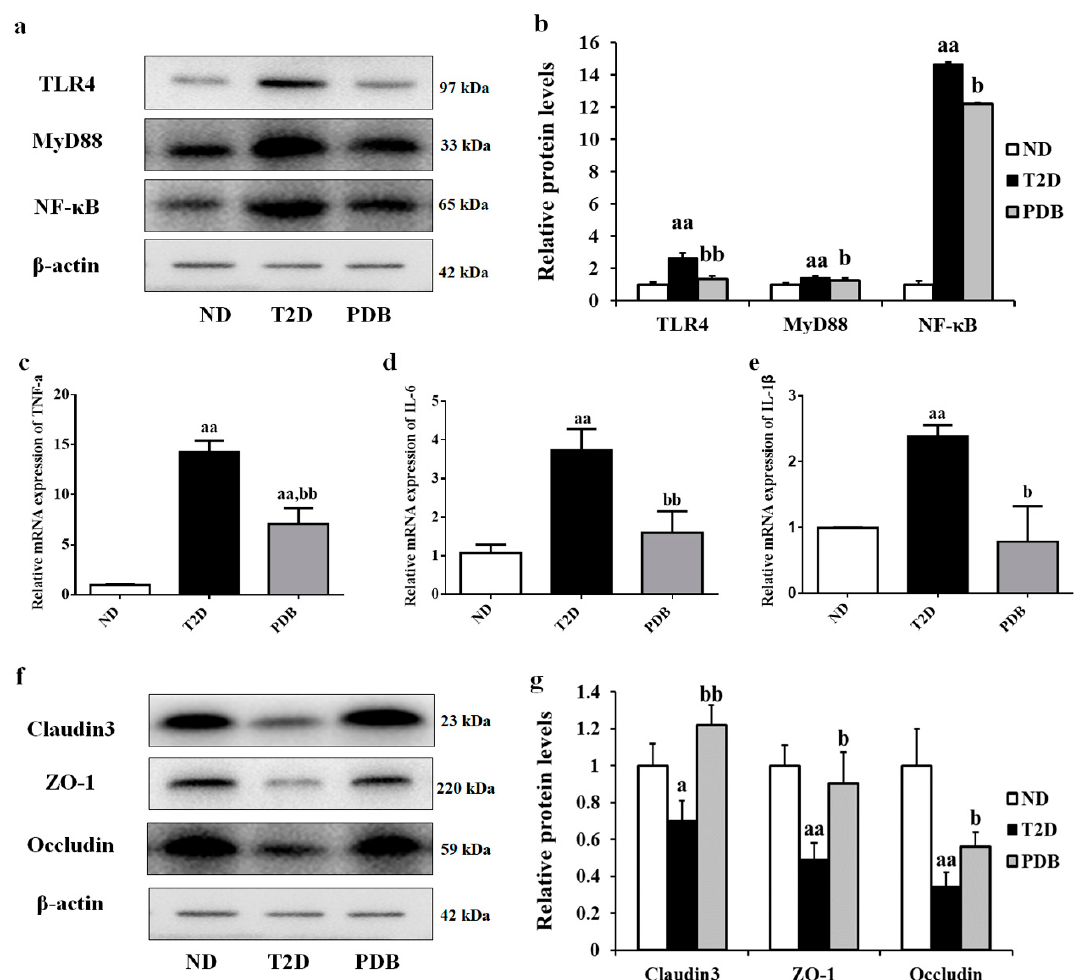
Figure 7. Effects of PDB on intestinal inflammation and intestinal mucosal barrier function of diabetic mice. The protein expression of TLR4, MyD88, NF- κ B ( a , b ), Claudin3, ZO-1, and Occludin ( f , g ) in colon tissue was determined by western blot. TNF- α ( c ), IL-6 ( d ), and IL-1 β ( e ) mRNA expression was measured by qRT-PCR. Data are presented as mean ± SD, n = 6. a p < 0.05, aa p < 0.01 versus the ND group. b p < 0.05, bb p < 0.01 versus the T2D group.